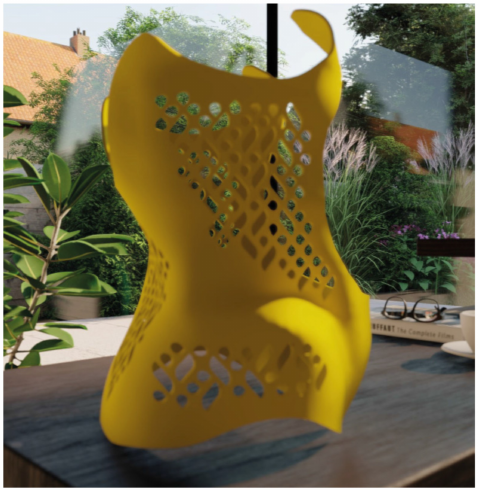
Figure 1. An example of a textured 3D-printed brace realised at the IPCB-Lecco lab (EMPA- TIA@LECCO, http://www.ipcb.cnr.it, accessed on 20 June